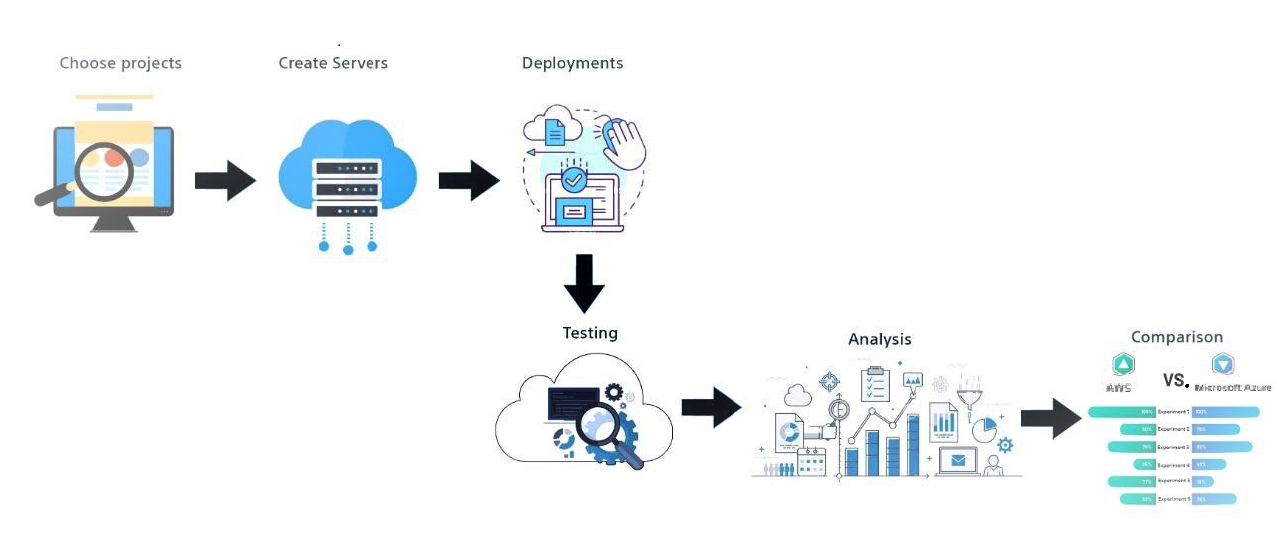
Figure 1. Steps of the experimental study.